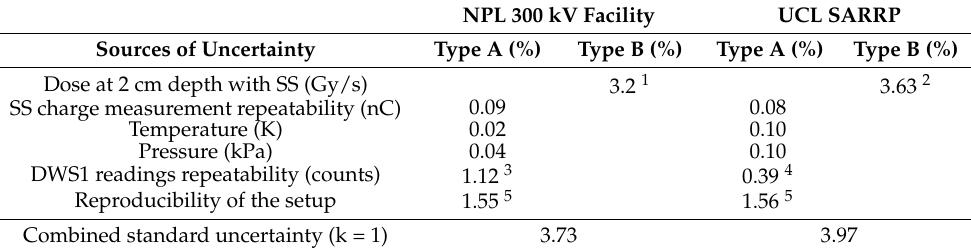
Table 5. Measurements recorded during the DWS1 cross-calibration at NPL 300 kV